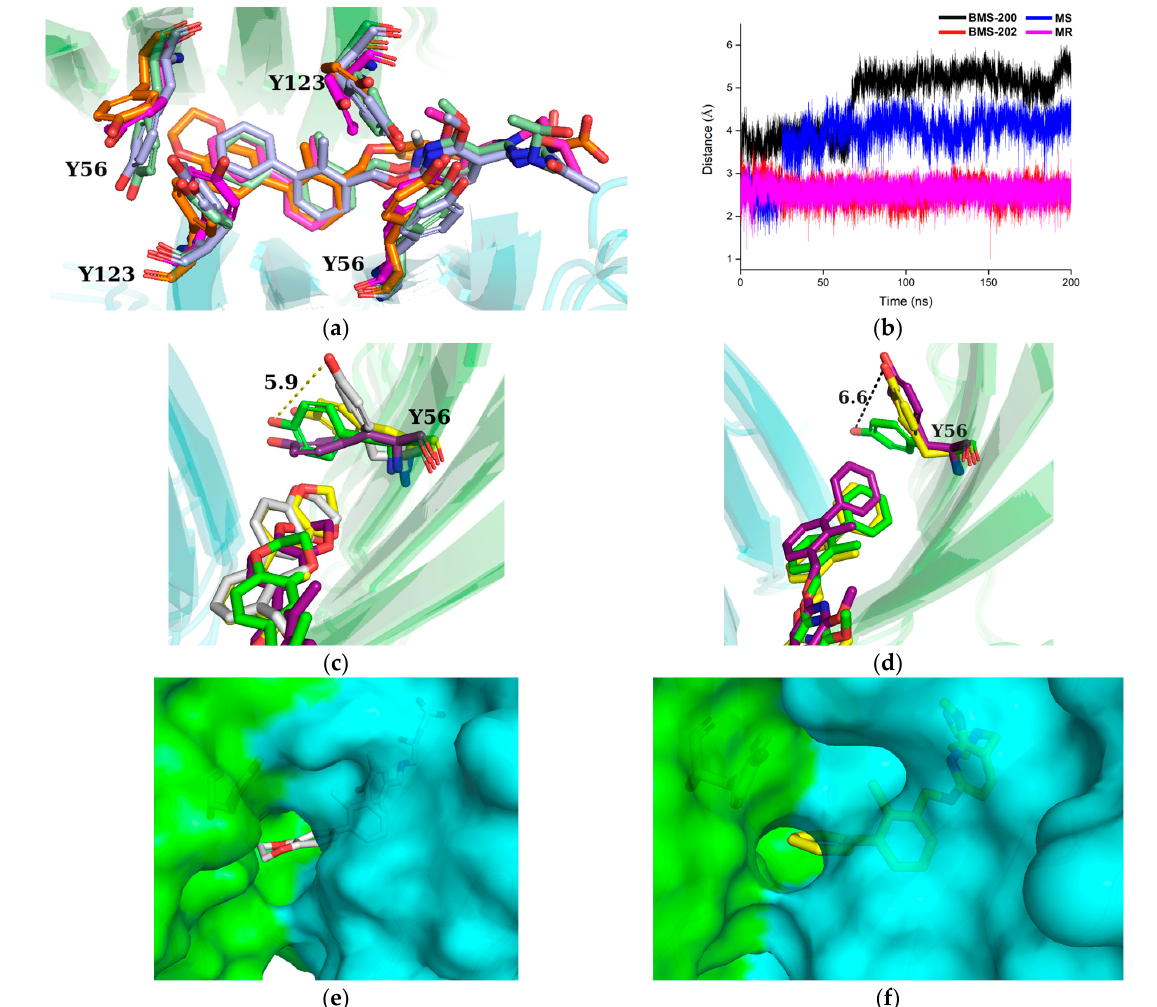
Figure 8. Conformational changes of the BMS-200 and MS systems during MD simulations. The side chain of residue A Tyr56 exhibited significant conformational rearrangement in the BMS-200 and MS systems. The hole formed at the bottom of the binding pocket turned the unilateral opening pocket into a through tunnel. ( a ) Conformational analysis by PD-L1 structural alignment. The BMS-200, BMS-202, MS, and MR systems are colored in orange, light blue, magenta, and pale green, respectively. ( b ) Minimum distance between the inhibitors and the geometric center of the side chain of A Tyr56. The curves were smoothed to remove irregular noisy data by the adjacent-averaging filter with five points of window. Motional visualization of the BMS-200 system ( c ) and MS system ( d ). The structure of each frame is colored in green, purple, yellow, and white, in chronological order. The distance between the two frames with the largest conformational difference is represented by the yellow dotted line. The conformational changes of the binding pocket (rear view) in the BMS-200 system ( e ) and MS system ( f ). The A PD-L1 and B PD-L1 are colored in green and cyan, respectively.